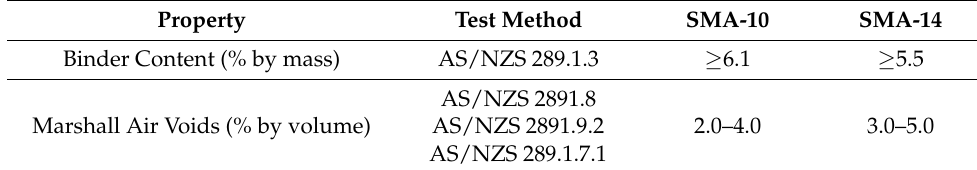
Table 3. SMA additional volumetric and related requirements [14].